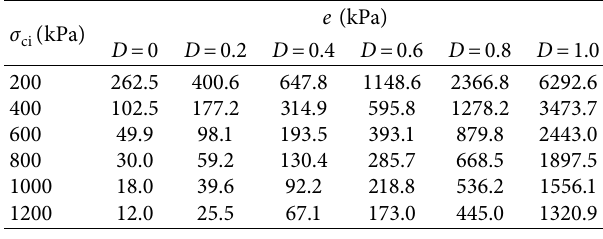
Table 8: Upper bound solution of the surrounding rock pressure e and D . at different σ ci